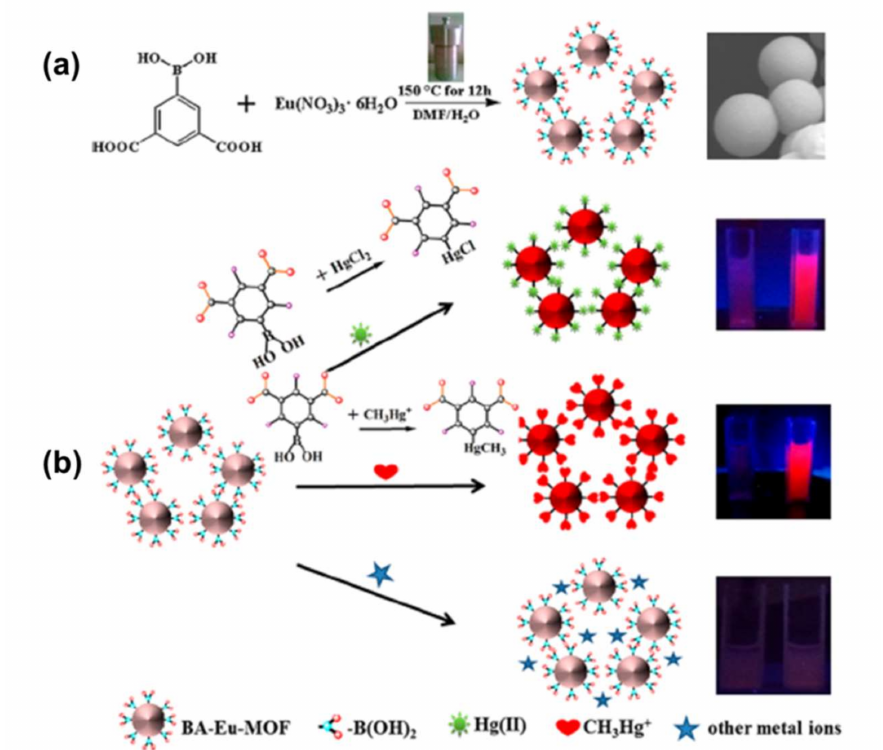
Figure 10. ( a ) Synthesis process of BA-Eu-MOF. ( b ) Schematic diagram of the sensing process of BA-Eu-MOF toward Hg 2+ and CH 3 Hg + ions based on transmetalation. Adapted from